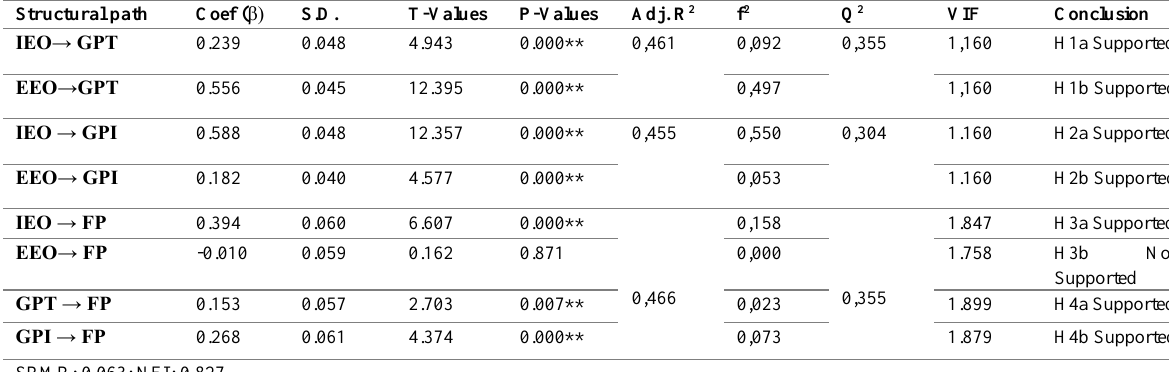
Table 4: Hypothesis Testing on Direct